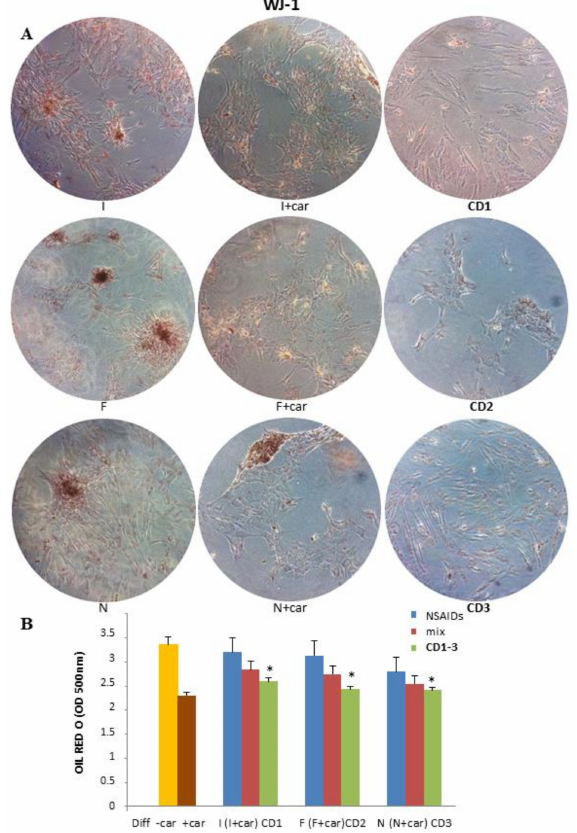
Figure 2. Effect of CD1-3 on adipocyte differentiation in subculture Wj1-MSCs cells. ( A ) The subculture WJ-1 was grown in an adipogenic differentiation medium until total differentiation (17 days) and treated with NSAIDs alone, a physical mixture of selected NSAID and 25 µ M Car, and CD1-3 . ( B ) The visualization of triglyceride accumulation was conducted by Oil Red O staining. Lipid accumulation was measured by spectrophotometry. Data are produced as the mean ± SD ( n = 3). * p < 0.05: treated cells vs. control (diff − Car) and Car (diff +